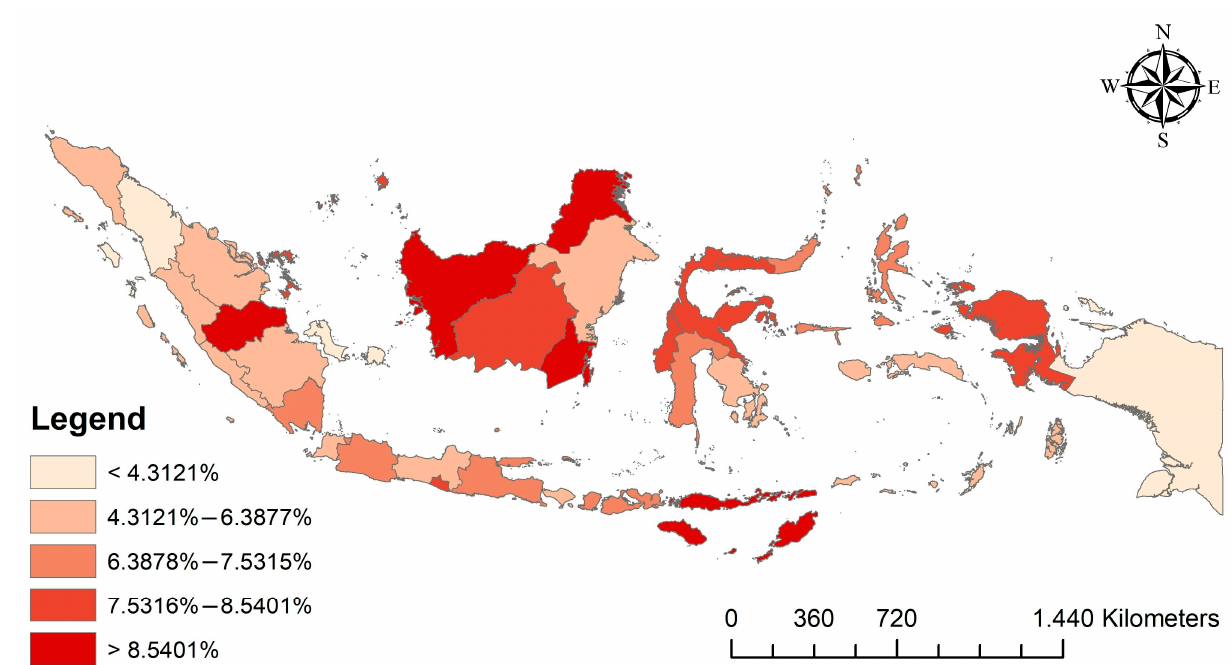
Figure 1. Distribution of LBW percentage by the province in Indonesia, 2017.